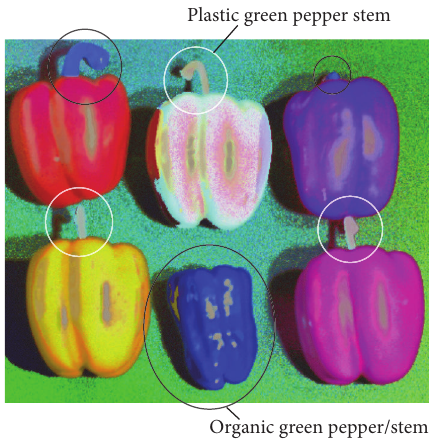
Figure 12: Figure 1(e), spectral gradient SOM display. The occur- rences of two materials in their respective color coding (blue and light gray) are annotated with